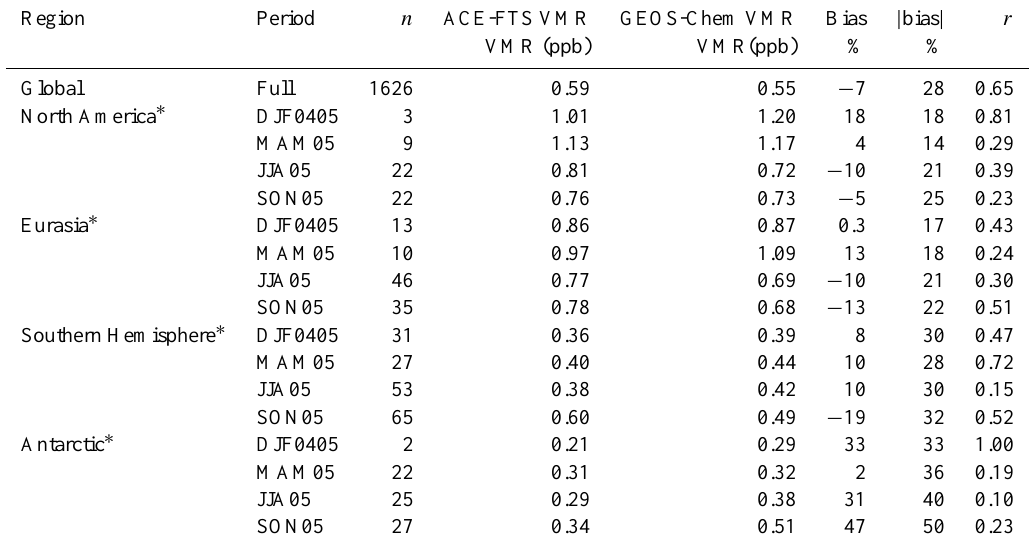
Table 3. Statistical comparison between ACE retrieved C 2 H 6 concentrations and GEOS-Chem output at 8.5km altitude; VMRs are expressed in ppb: n is the number of data taken into account, bias is the Mean Bias as defined by Eq. (1), | bias | is the Mean Absolute Bias as defined by Eq. (2) and r is the correlation coefficient.